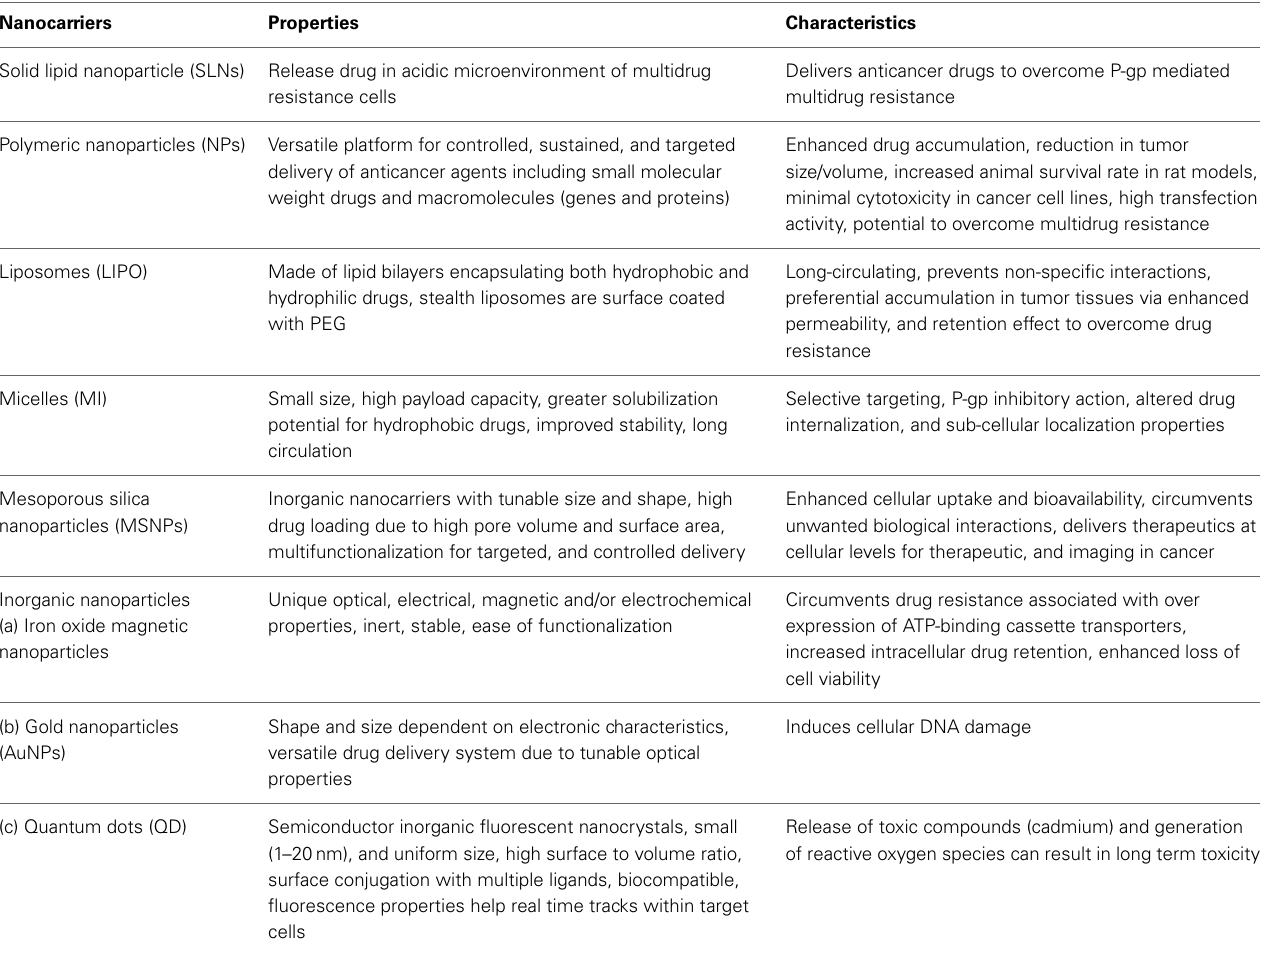
Table 3 | Chemotherapeutic nanodrug delivery